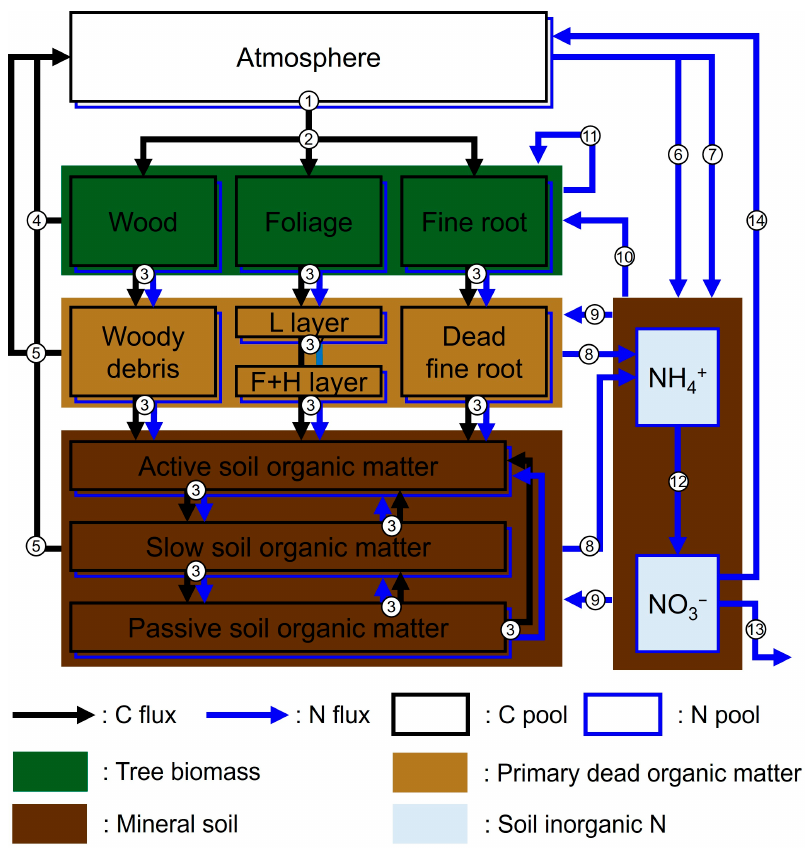
Figure A1. The structure of the Forest Biomass and Dead organic matter Carbon and Nitrogen (derived from Kim et al. [19]). ① Photosynthesis; ② C allocation; ③ Turnover; ④ Autotrophic respiration; ⑤ Heterotrophic respiration; ⑥ N deposition; ⑦ Biological N fixation; ⑧ N mineralization; ⑨ N immobilization; ⑩ Tree N uptake; ⑪ N resorption at turnover of foliage and fine root; ⑫ Nitrification; ⑬ N leaching; and ⑭ Denitrification). L and F+H layers denote the litter layer and the combined layer of fermentation and humus layers, respectively.